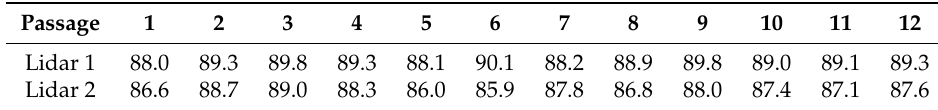
Table 2. Percentages of scans that were registered correctly by each of the lasers in each of the scanned